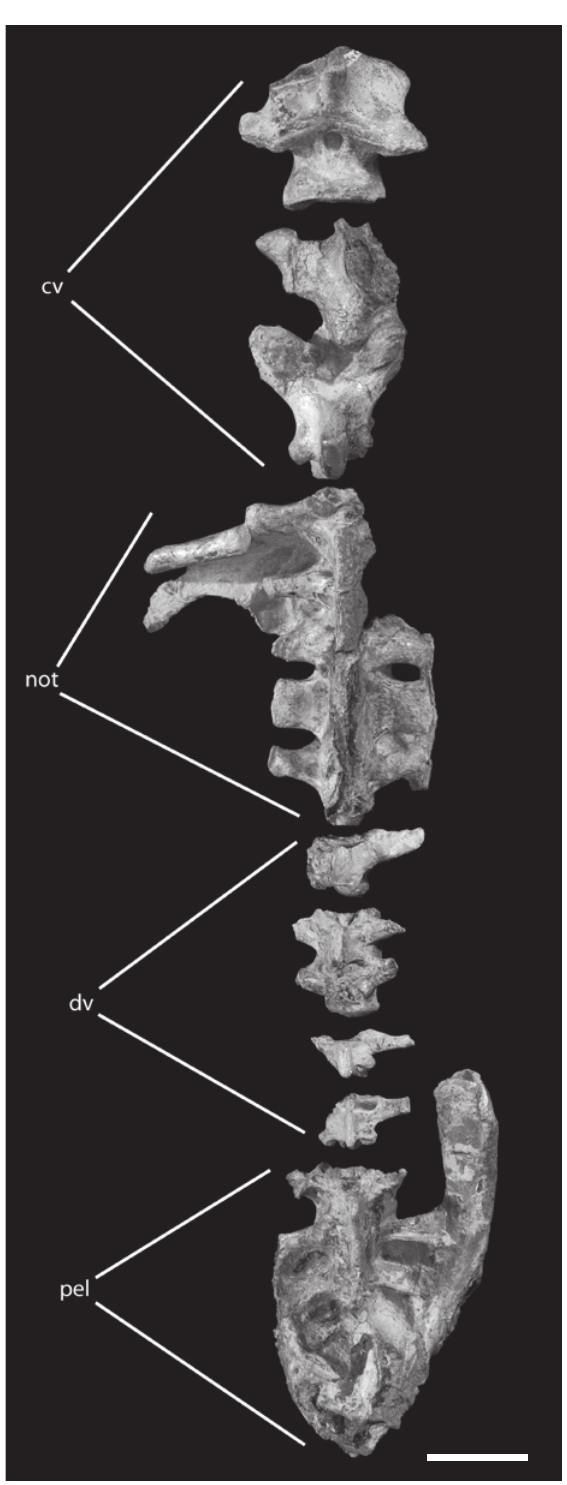
Fig. 5 - Vertebral column of Tropeognathus cf. T. mesembrinus (MN 6594-V) in dorsal view. See text for abbreviations. Scale bar 50